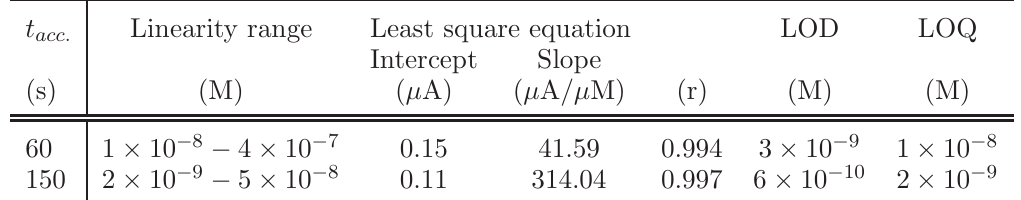
Table 1 Characteristics of calibration plots of SW-AdCS voltammetric determination of bulk tolmetin in a perchloric acid solution of pH